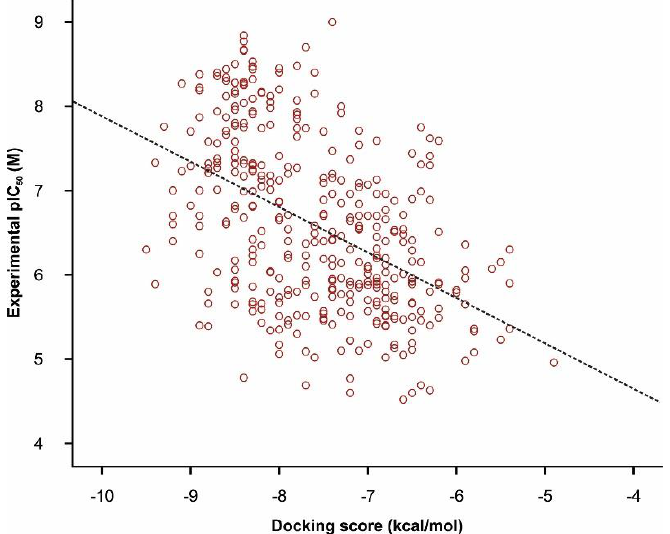
Figure 6. Correlation plot between experimental pIC 50 (M) and docking scores (kcal / mol) of TRPA1 antagonists ( R 2 = 0.226) in molecular docking simulations.